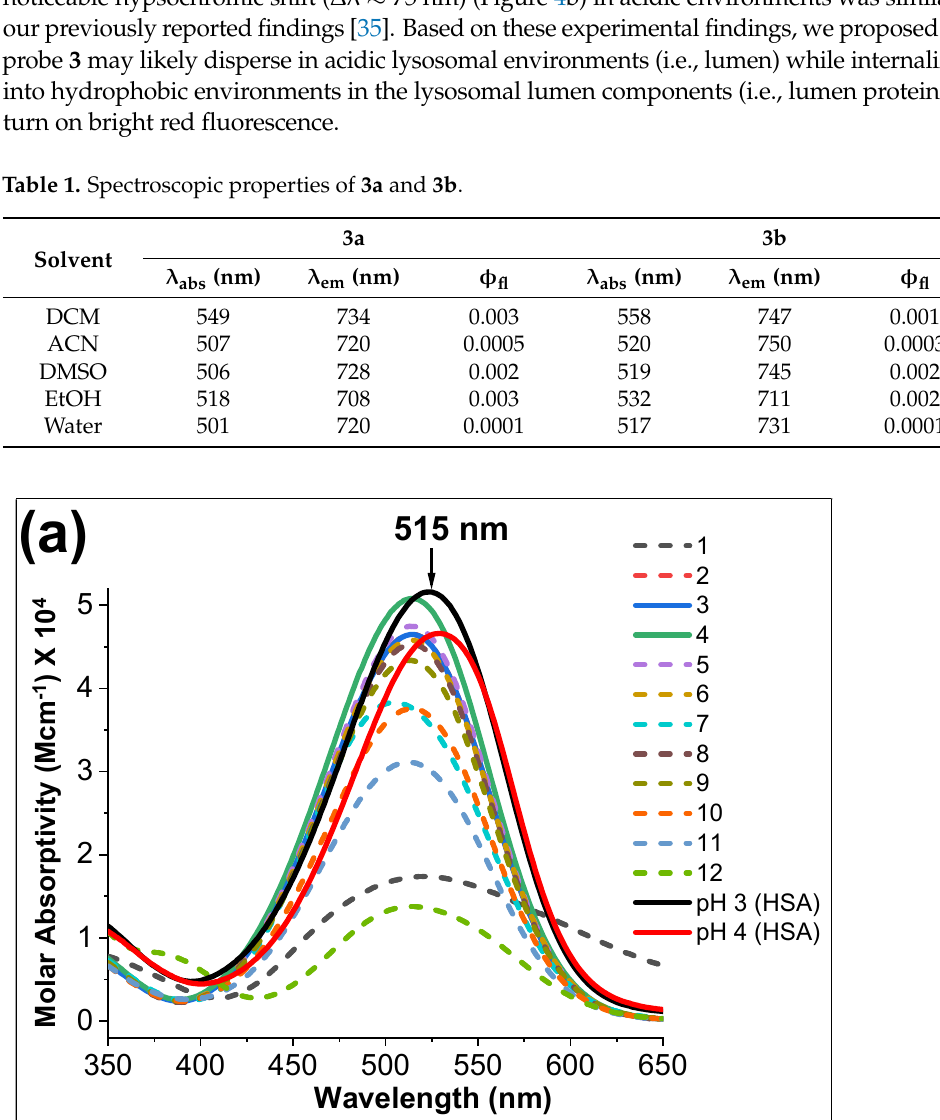
Figure 4. Absorption ( a ) and fluorescence ( b ) spectra were recorded for 3b (1 × 10 −5 M) in different aqueous acidic environments. At pH, 10 µL of 10% HSA solution was introduced into the acidic solutions of probe 3b . The probe was excited at 510 nm and the emission was recorded from 550 nm to 800 nm.